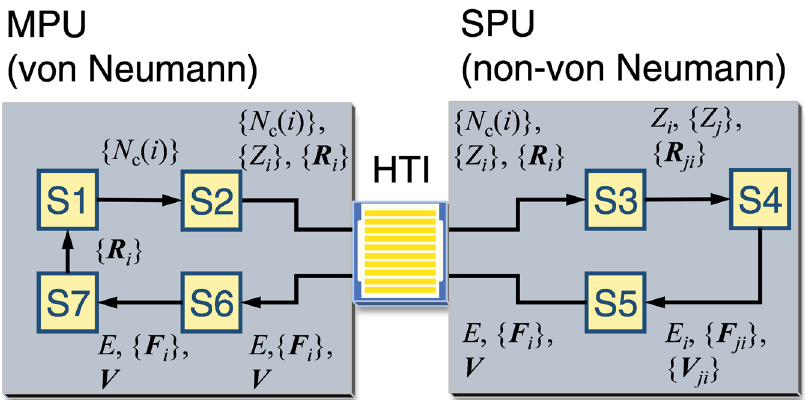
Fig. 5 Schematic fi gure of heterogeneous parallelization in the NVNMD system. The system consists of master processing unit (MPU), slave processing unit (SPU), and high-speed transmission interface (HTI). Calculation of each timestep of MD in the system consists of seven consecutive steps: building neighbor list (S1); encoding atomic information into compact data (S2); receiving and decoding atomic compact data (S3); evaluating potential energy surface (PES) (S4); encoding and sending data of PES (S5), decoding data of PES (S6), and other calculations, e.g., numerical integration (S7). Here, E and V represent the energy and virial of atomic system, respectively; Z i , R i , E i , F i , and N c ( i ) represent the chemical specie, coordinate, energy, force, and neighbor list of atom i , respectively; R ji , F ji , and V ji represent the relative coordinate, force component, and virial component between atom i and atom j .